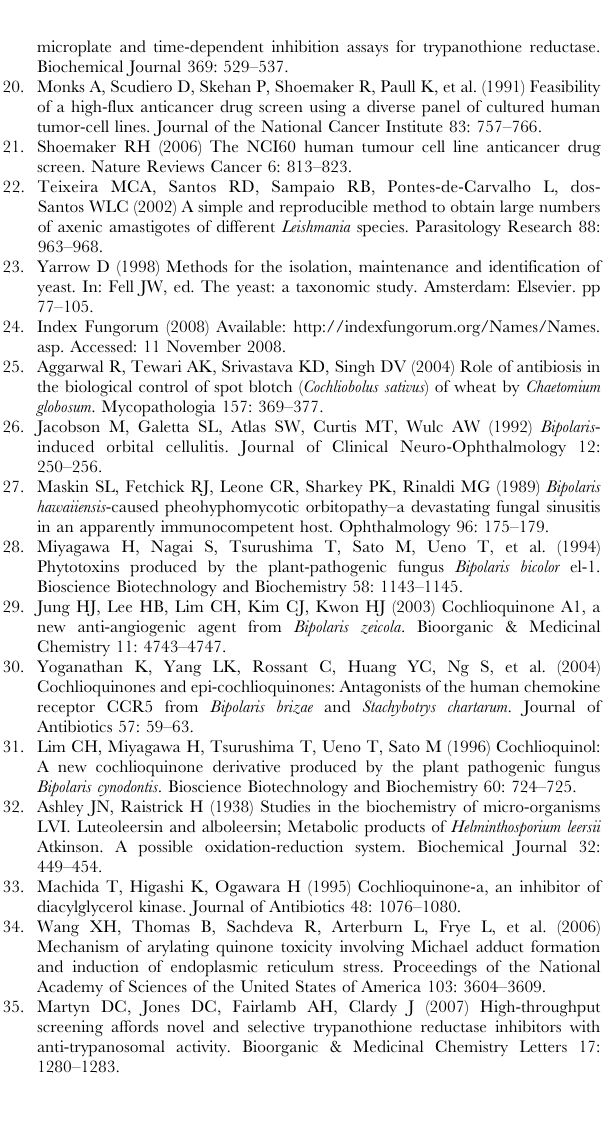
Figure S1 1 H and 13 C NMR spectra of the isolated